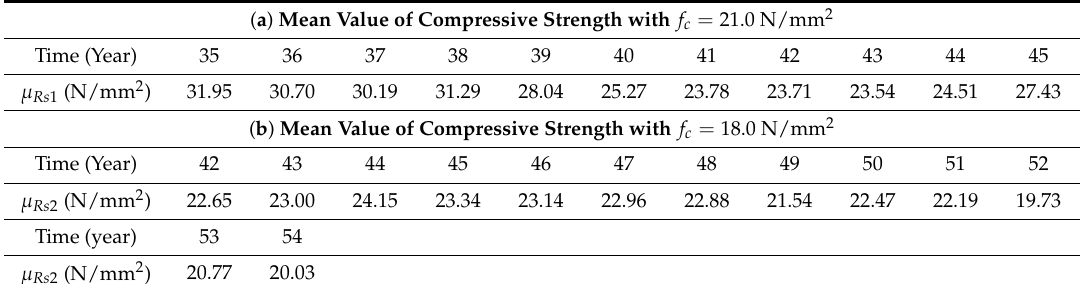
Table 2. Mean value of compressive strength with ( a )